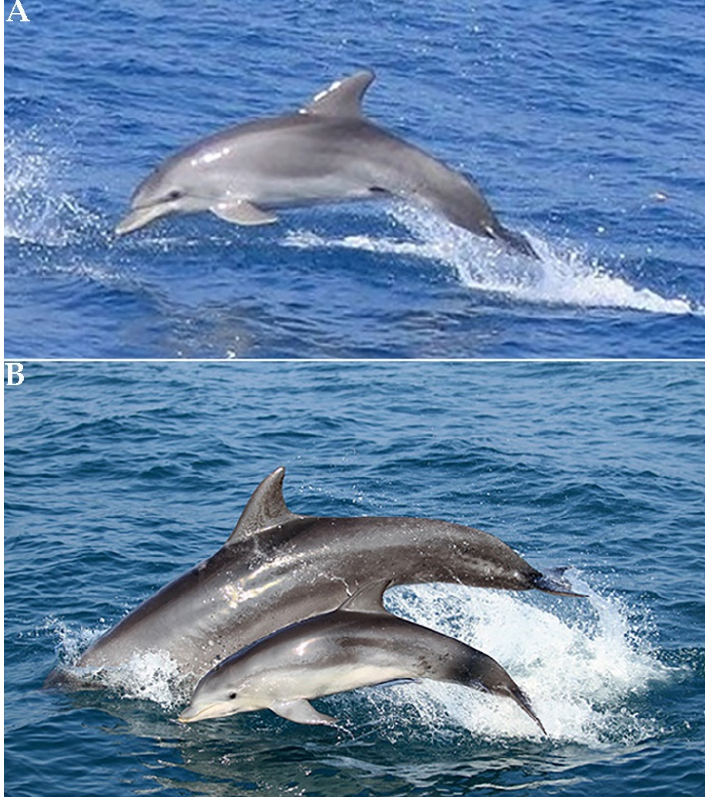
Figure 9. Common bottlenose dolphin, Tursiops truncatus , off the Mediterranean coast of Israel ( A ) and with a cub ( B ) (photograph by Aviad Scheinin).